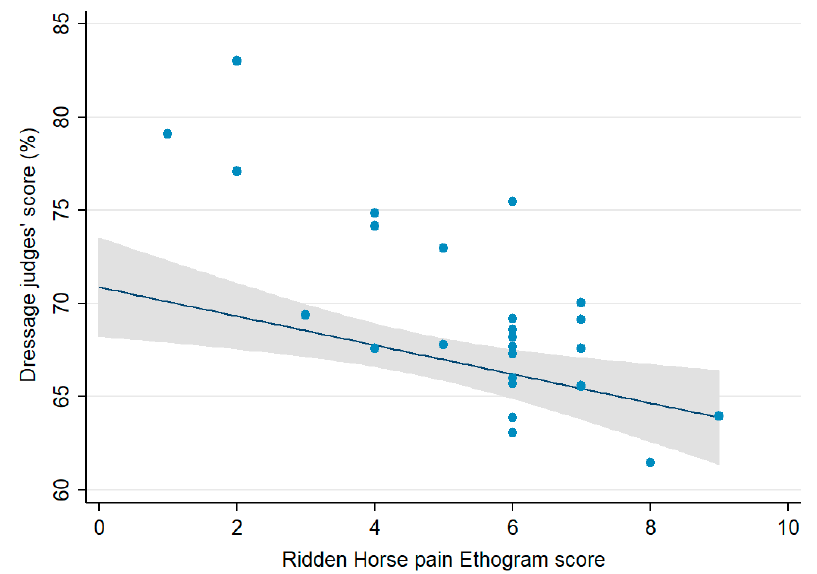
Figure 1. Comparison of the dressage judges’ percentage scores and the Ridden Horse Pain Ethogram scores (0–24) for horses competing at the British Dressage Grand Prix National Championship 2020 ( n = 26), showing the individual scores, fitted line prediction and 95% confidence interval (CI). There was a moderate negative correlation, Spearman’s rho − 0.6648, p = 0.0002.